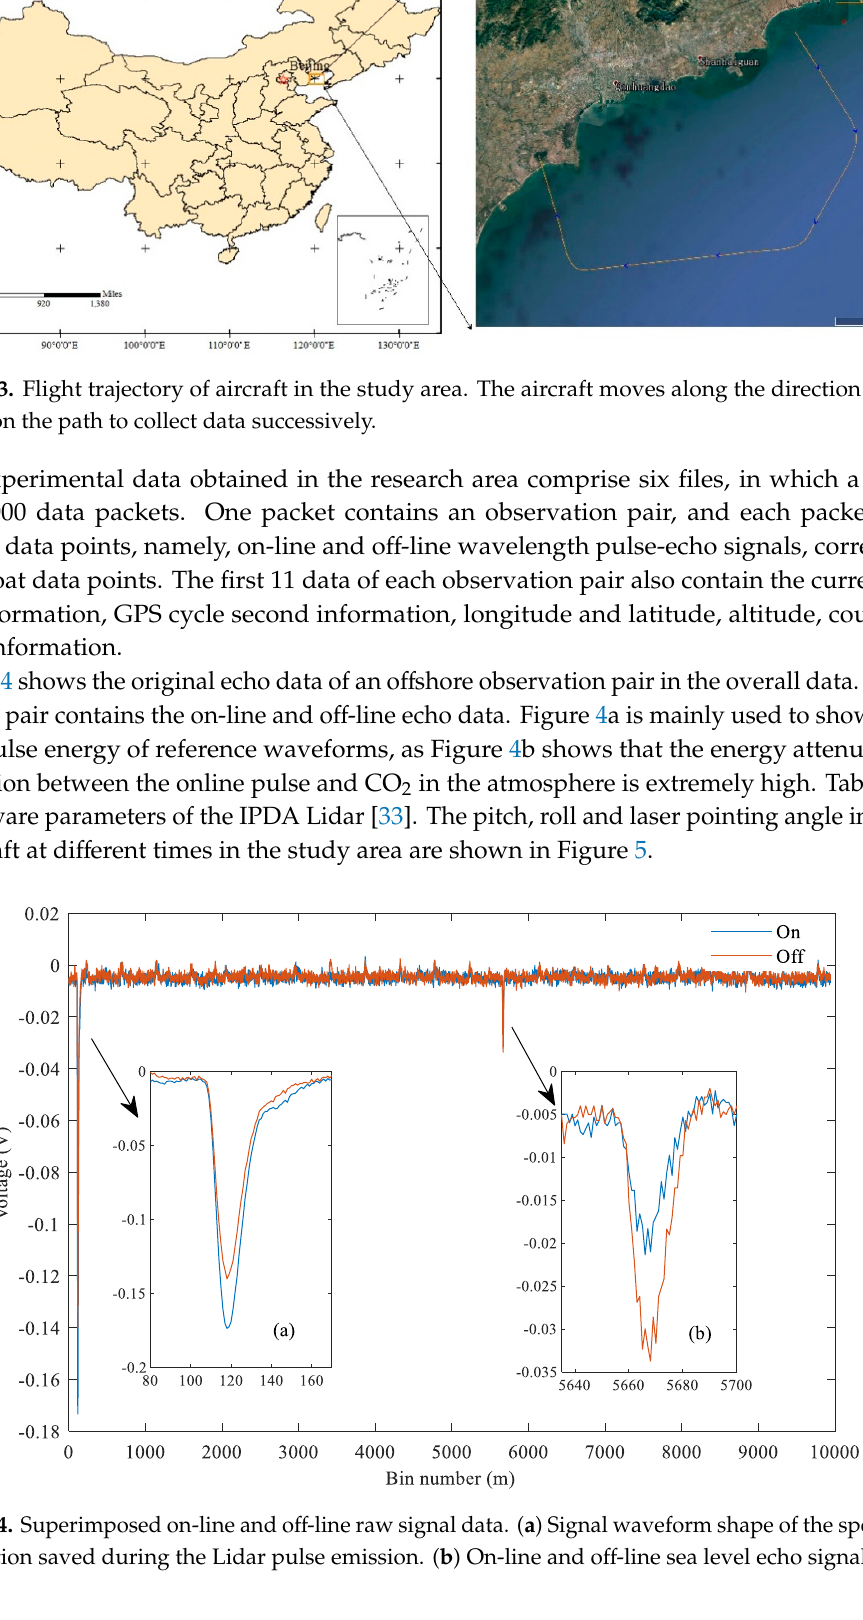
Figure 5. Airborne angle information. The corrected pitch angle, roll angle, and laser pointing angle are shown, respectively. The angle between the laser beam pointing and the vertical line is called the laser pointing angle, which is calculated from the pitch and the roll angle by using equation (2). There are two breakpoints in the graph because there is one second missing data at two different locations in the original data. 2.1